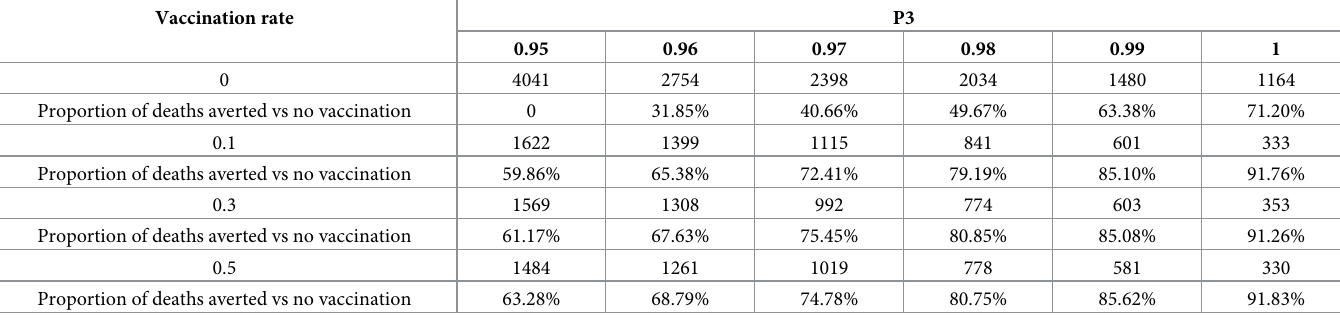
Proportion of deaths averted vs no vaccination